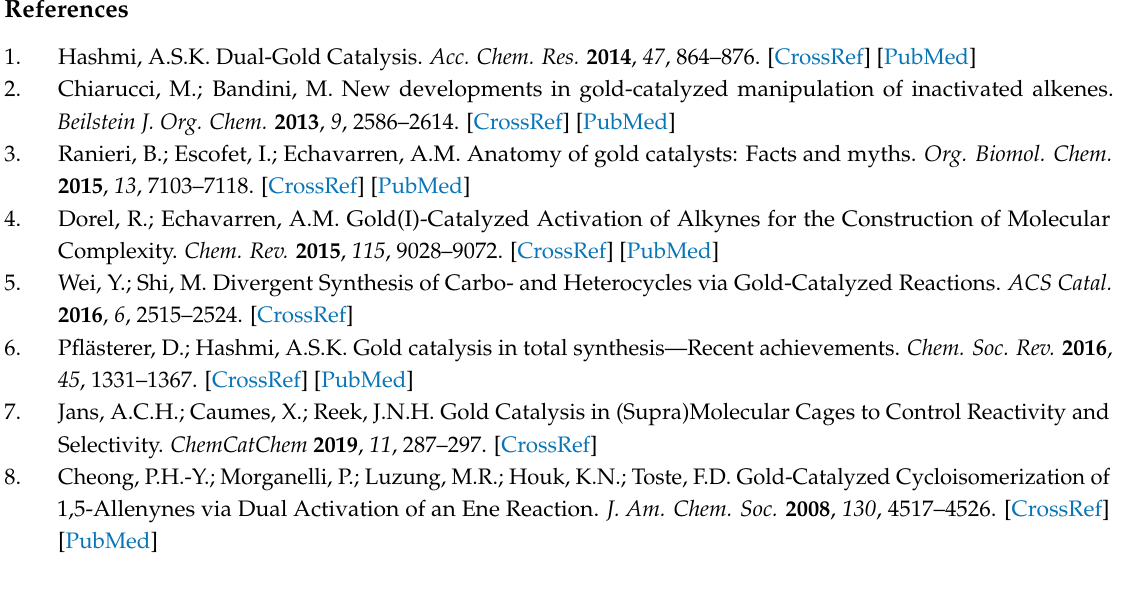
Figure S1: 31 P{ 1 H} NMR spectrum of complex 1 (CD 2 Cl 2 , 298 K, 162 MHz), Figure S2: 1 H NMR spectrum of complex 1 (CD 2 Cl 2 , 298 K, 500 MHz), Figure S3: 13 C{ 1 H} NMR spectrum of complex 1 (CD 2 Cl 2 , 298 K, 126 MHz), Figure 4: Connectivity plot of complex 1 , Figure S5: 31 P{ 1 H} NMR spectrum of complex 2 (CD 2 Cl 2 , 298 K, 162 MHz), Figure S6: 1 H NMR spectrum of complex 2 (CD 2 Cl 2 , 298 K, 500 MHz), Figure S7: 13 C{ 1 H} NMR spectrum of complex 2 (CD 2 Cl 2 , 298 K, 126 MHz), Figure S8: 31 P{ 1 H} NMR spectrum of complex 3 (CD 2 Cl 2 , 298 K, 162 MHz), Figure S9: 1 H NMR spectrum of complex 3 (CD 2 Cl 2 , 298 K, 500 MHz), Figure S10: 13 C{ 1 H} NMR spectrum of complex 3 (CD 2 Cl 2 , 298 K, 126 MHz), Figure S11: 31 P{ 1 H} NMR spectrum of complex 4 (CD 2 Cl 2 , 298 K, 162 MHz), Figure S12: 1 H NMR spectrum of complex 4 (CD 2 Cl 2 , 298 K, 500 MHz), Figure S13: 13 C{ 1 H} NMR spectrum of complex 4 (CD 2 Cl 2 , 298 K, 126 MHz), Figure S14: 31 P{ 1 H} NMR spectrum of complex 5 (CD 2 Cl 2 , 298 K, 162 MHz), Figure S15: 1 H NMR spectrum of product B (98%) and C (2%) (CDCl 3 , 298 K, 400 MHz), obtained by using complex 1 and two equivalents AgSbF 6 , Figure S16: 1 H NMR spectrum of product B (100%) (CDCl 3 , 298 K, 400 MHz), obtained by using complex 2 and two equivalents AgSbF 6 , Figure S17: 1 H NMR spectrum of product B (97%) and C (3%) (CDCl 3 , 298 K, 400 MHz), obtained by using complex 3 and one equivalent AgSbF 6 , Figure S18: 1 H NMR spectrum of product B (95%) and C (5%) (CDCl 3 , 298 K, 400 MHz), obtained by using complex 4 and one equivalent AgSbF 6 , Figure S19: 1 H NMR spectrum of substrate D (acetone-d 6 , 298 K, 300 MHz), Figure S20: 1 H NMR spectrum of product E (acetone-d 6 , 298 K, 300 MHz), Figure S21: 1 H NMR spectrum of substrate F (CDCl 3 , 298 K, 300 MHz), Figure S22: 1 H NMR spectrum of product G (CDCl 3 , 298 K, 300 MHz); CIF and checkCIF data for complexes 2 , 3, and 5